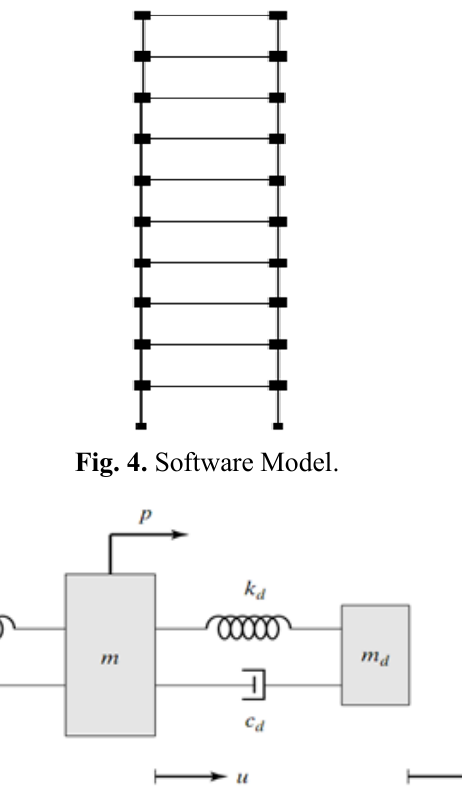
Fig. 5. A system with 1 DOF, Equipped with a TDM.